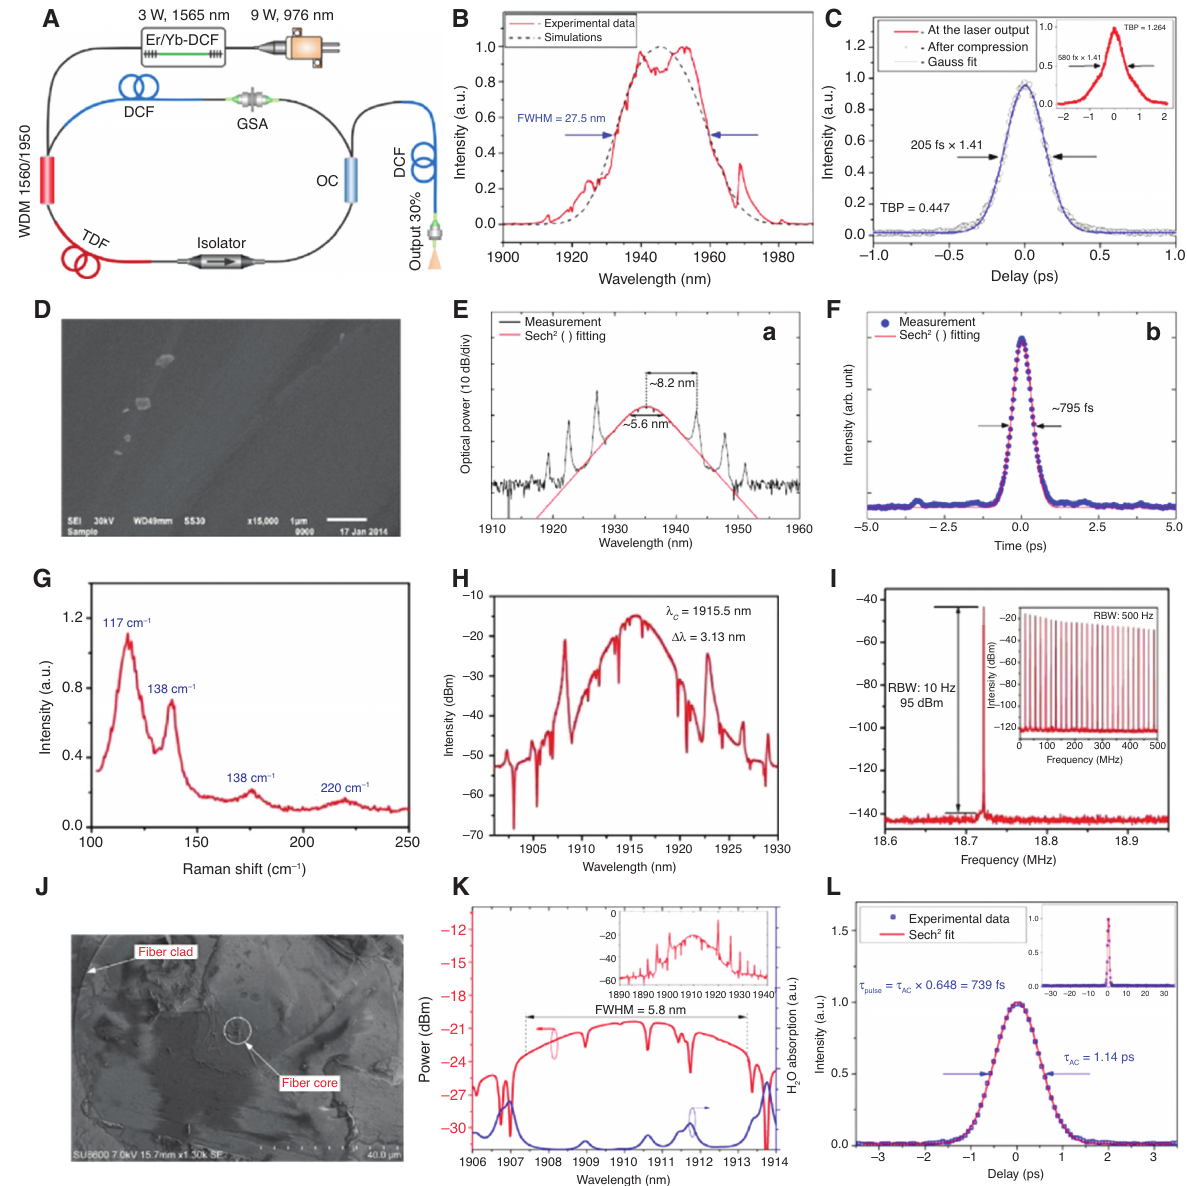
Figure 13: Mode-locked fiber lasers with various SAs at the 2.0- μ m region. (A–C) Graphene. (A) Schematic of fiber laser. (B) Optical spectrum. (C) Autocorrelation traces. Reproduced with permission from Ref. [366]. Copyright 2017, Optical Society of America. (D–F) Bi permission from Ref. [21]. Copyright 2014, Optical Society of America. (G–I) WTe